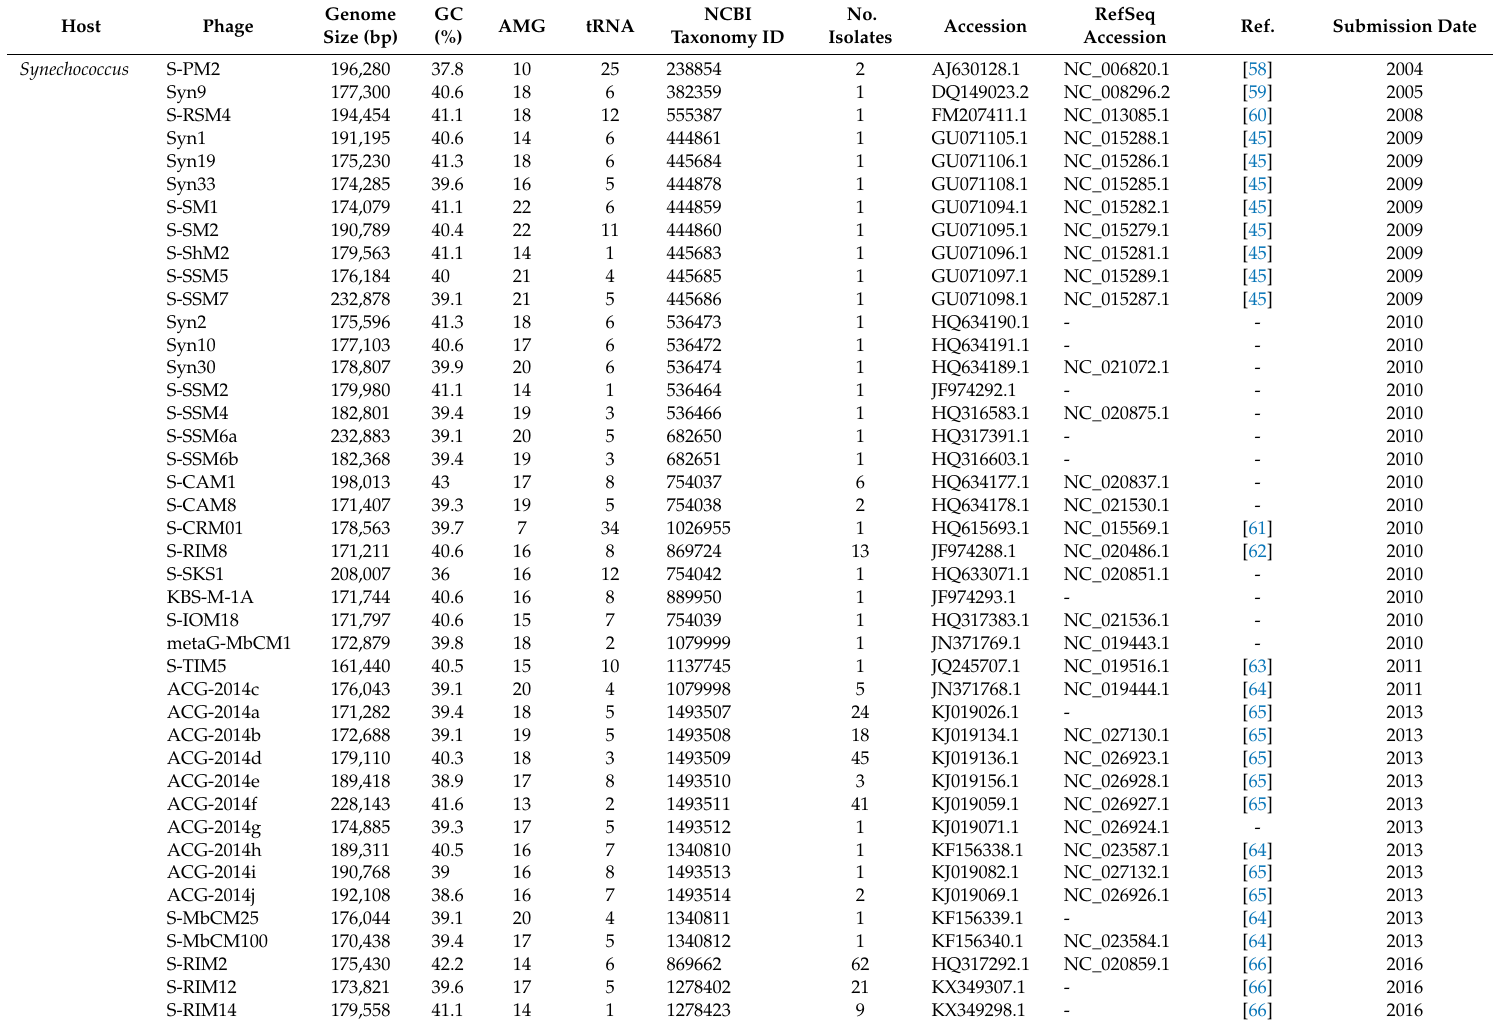
Table 1. General genomic features of 81 representative